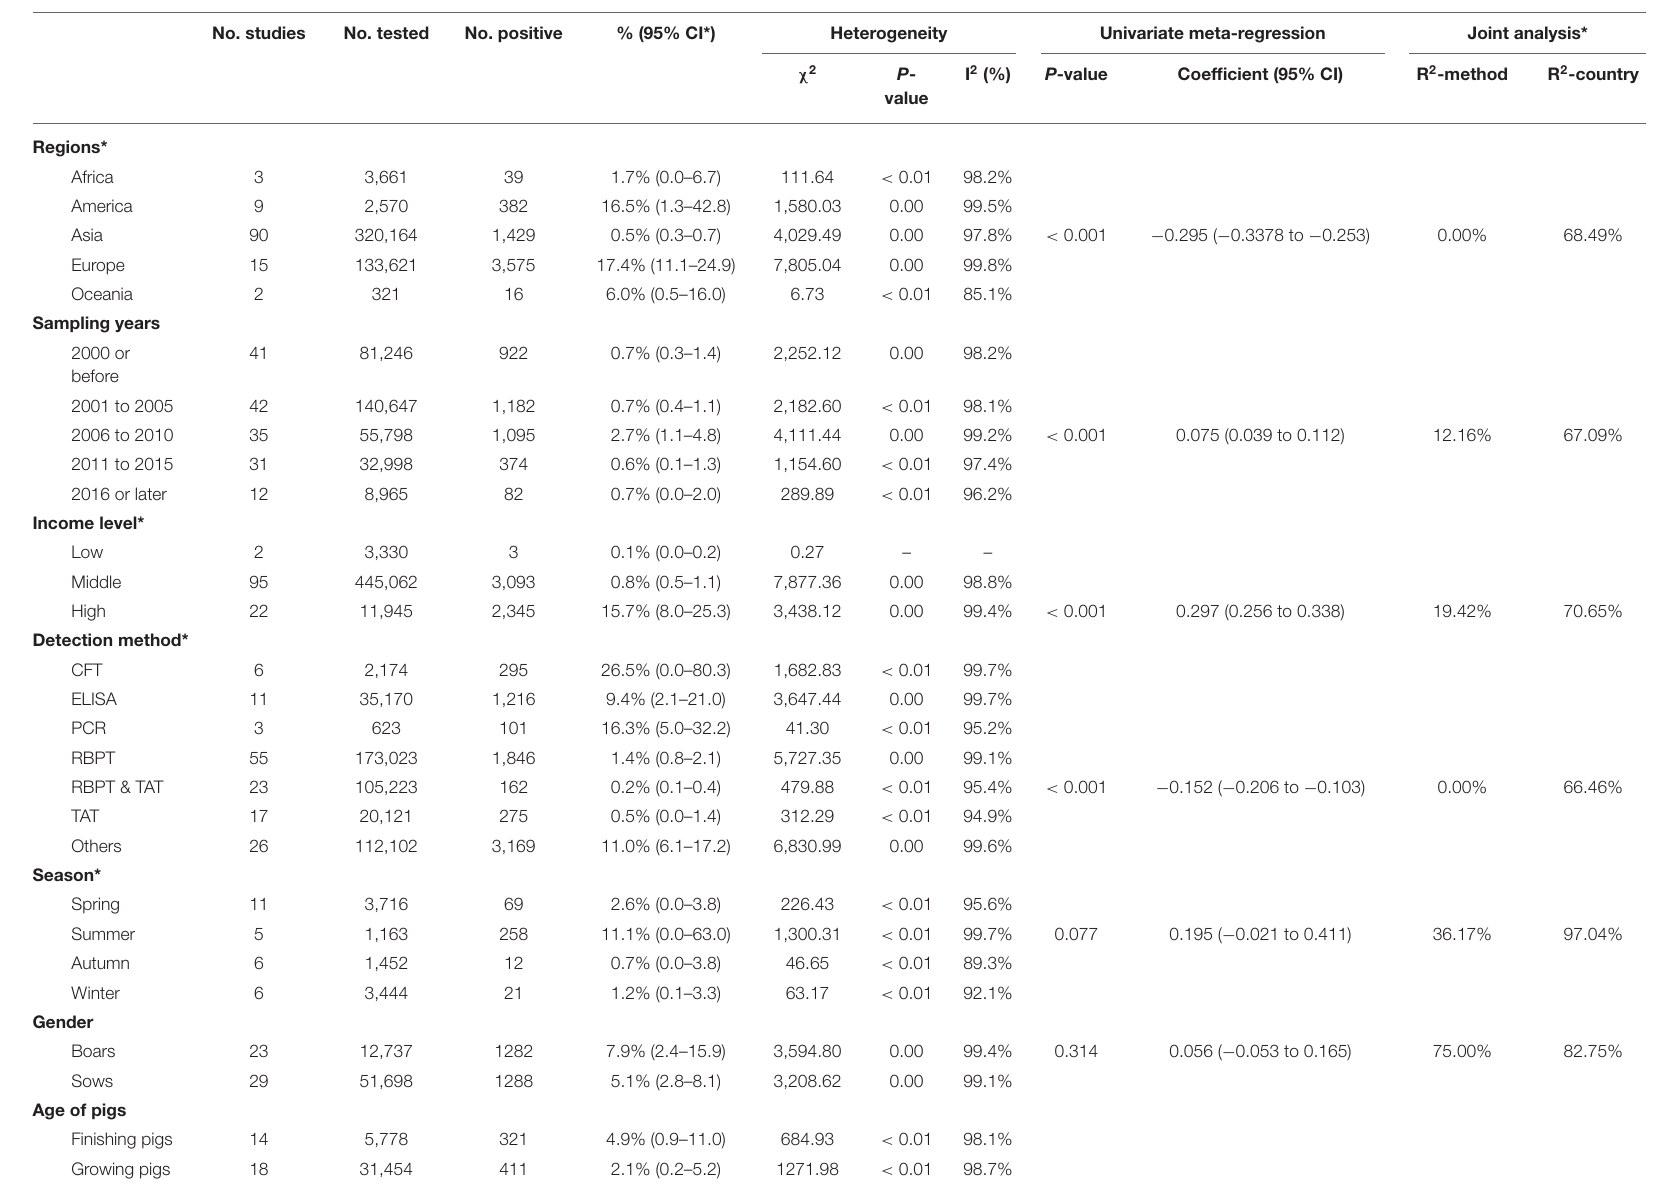
TABLE 2 | Pooled worldwide prevalence of Brucella spp. by